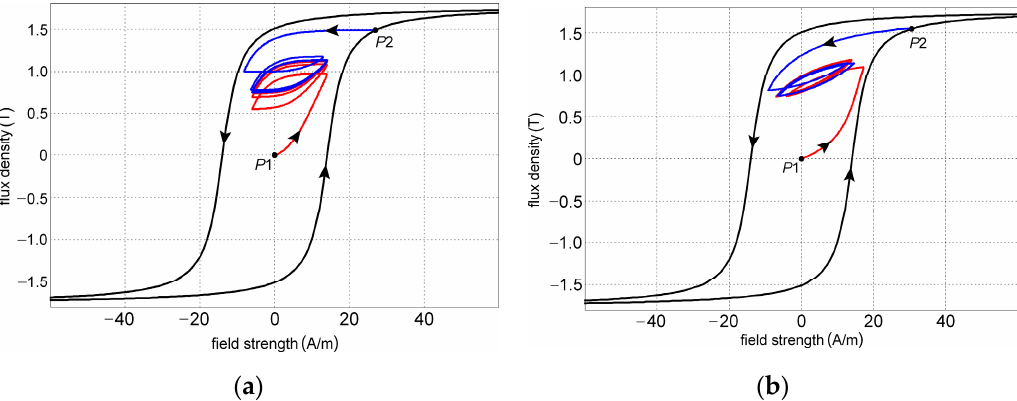
Figure 9. Examples of minor loops when the field strength or flux density has a constant component calculated using the approximations ( a ) B = f ( H ) and ( b ) H = f ( B ).